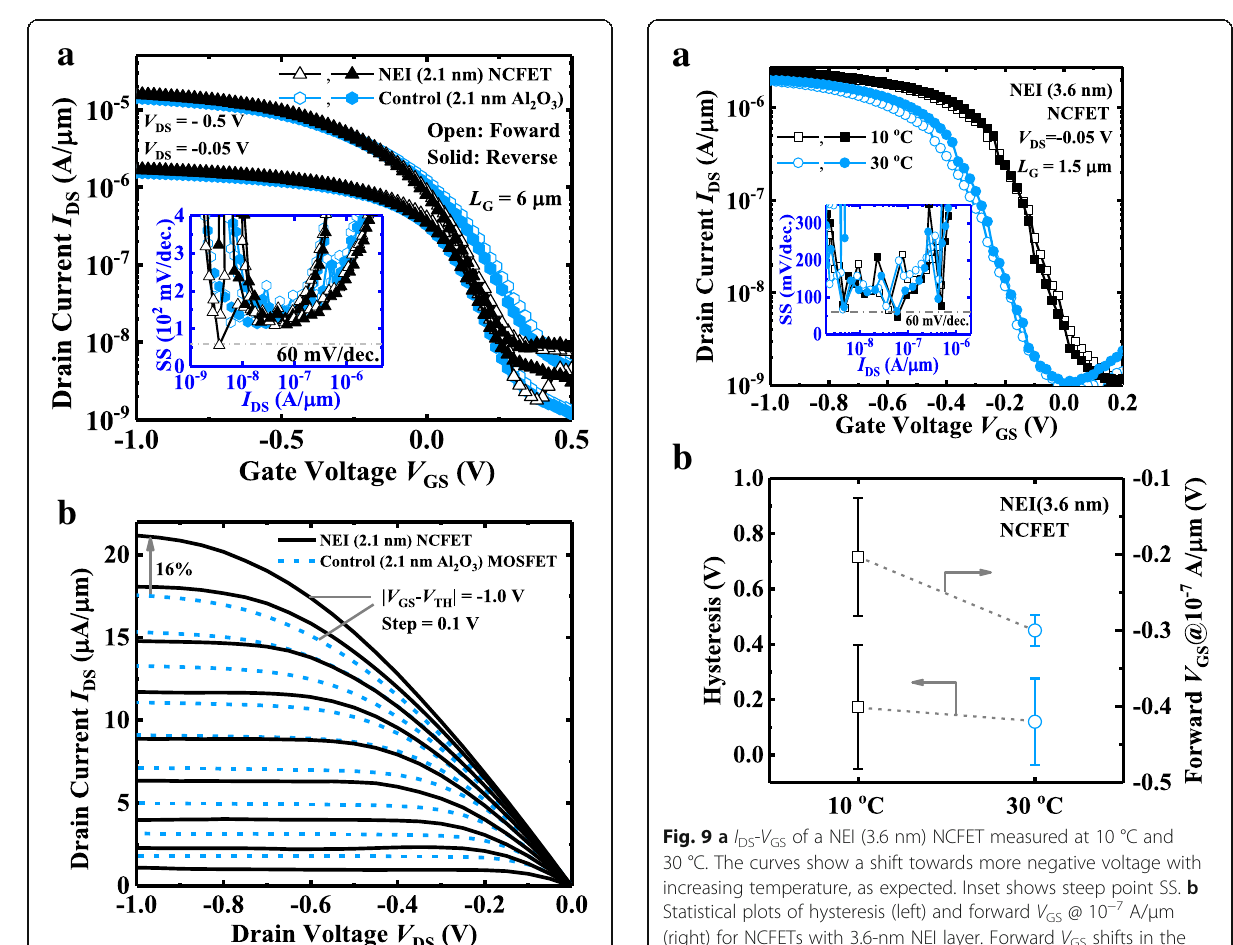
Figure 12 benchmarks the NEI FeFET memory device